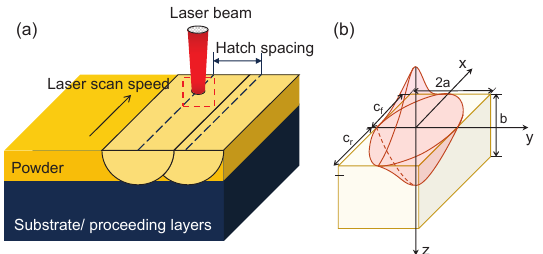
Figure 1. ( a ) Schematic diagram of SLM processing process; ( b ) Goldak’s double-ellipsoidal power density distribution model [26].